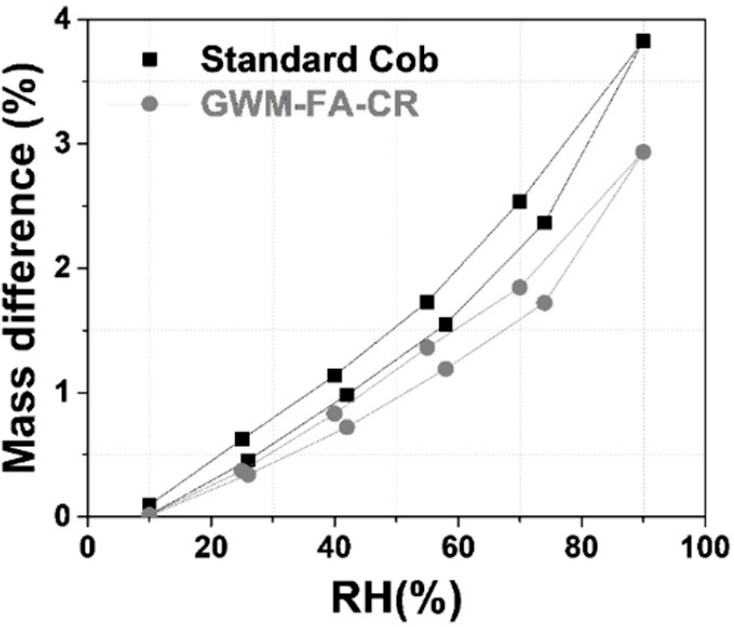
Figure 8. Moisture sorption isotherm of the GWM-FA-CR mix and a cob material at room temperature. Table 10. Porosity Measured on the Cob Material and GWM-FA-CR Mix.